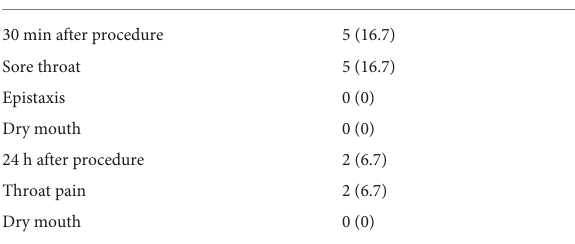
TABLE 7 Adverse events related to oxygen delivery system ( n =